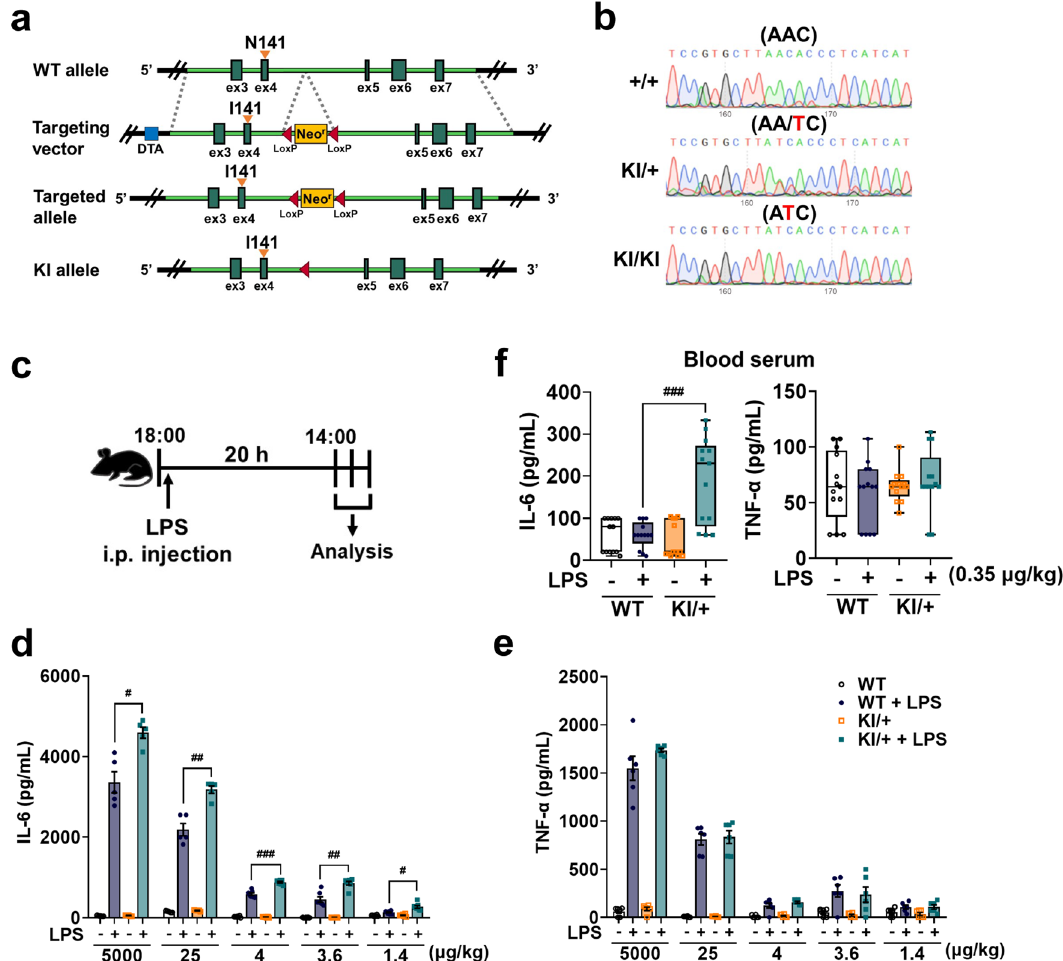
Fig. 1 LPS injection elicits overactive response of IL-6 but not TNF- α in Psen2 N141I/ + mice. a Strategy for targeted insertion of the N141I point mutation into the murine Psen2 locus to generate a KI mouse model. b Sanger sequencing chromatograms of genomic DNA from wild type (WT), Psen2 N141I/ + (KI/ + ), and Psen2 N141I/N141I (KI/KI) mice. c Schematic illustration of the experimental schedule. d , e ELISA of IL-6 ( d ) ( n = 5 mice for 5000 and 25 μ g/kg LPS- injection group; n = 7 mice for 4, 3.6, and 1.4 μ g/kg LPS-injection group) (LPS-injected WT vs LPS-injected KI/ + : # p = 0.0343, ## p = 0.0061, ###